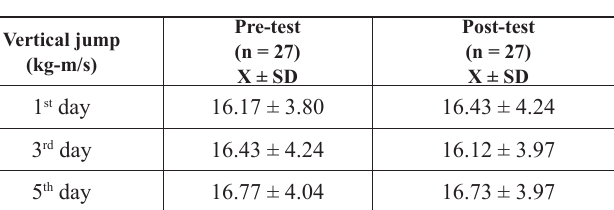
Table 2. The vertical jump mean (SD)